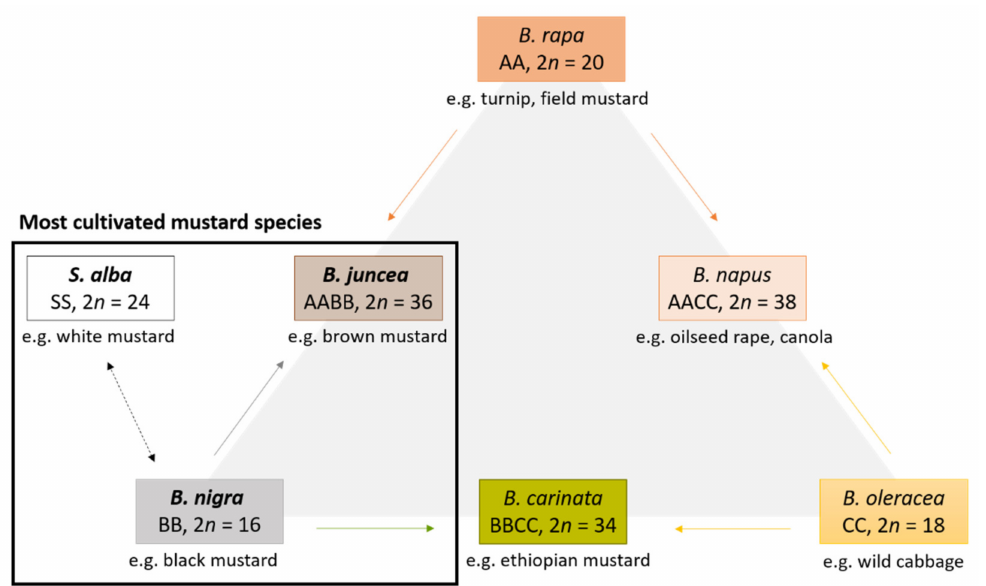
Figure 1. Taxa, genomes, chromosome number (n) and genetic relationship among Brassica species represented by U’s triangle. The most cultivated mustard species that are subject of this article are framed in